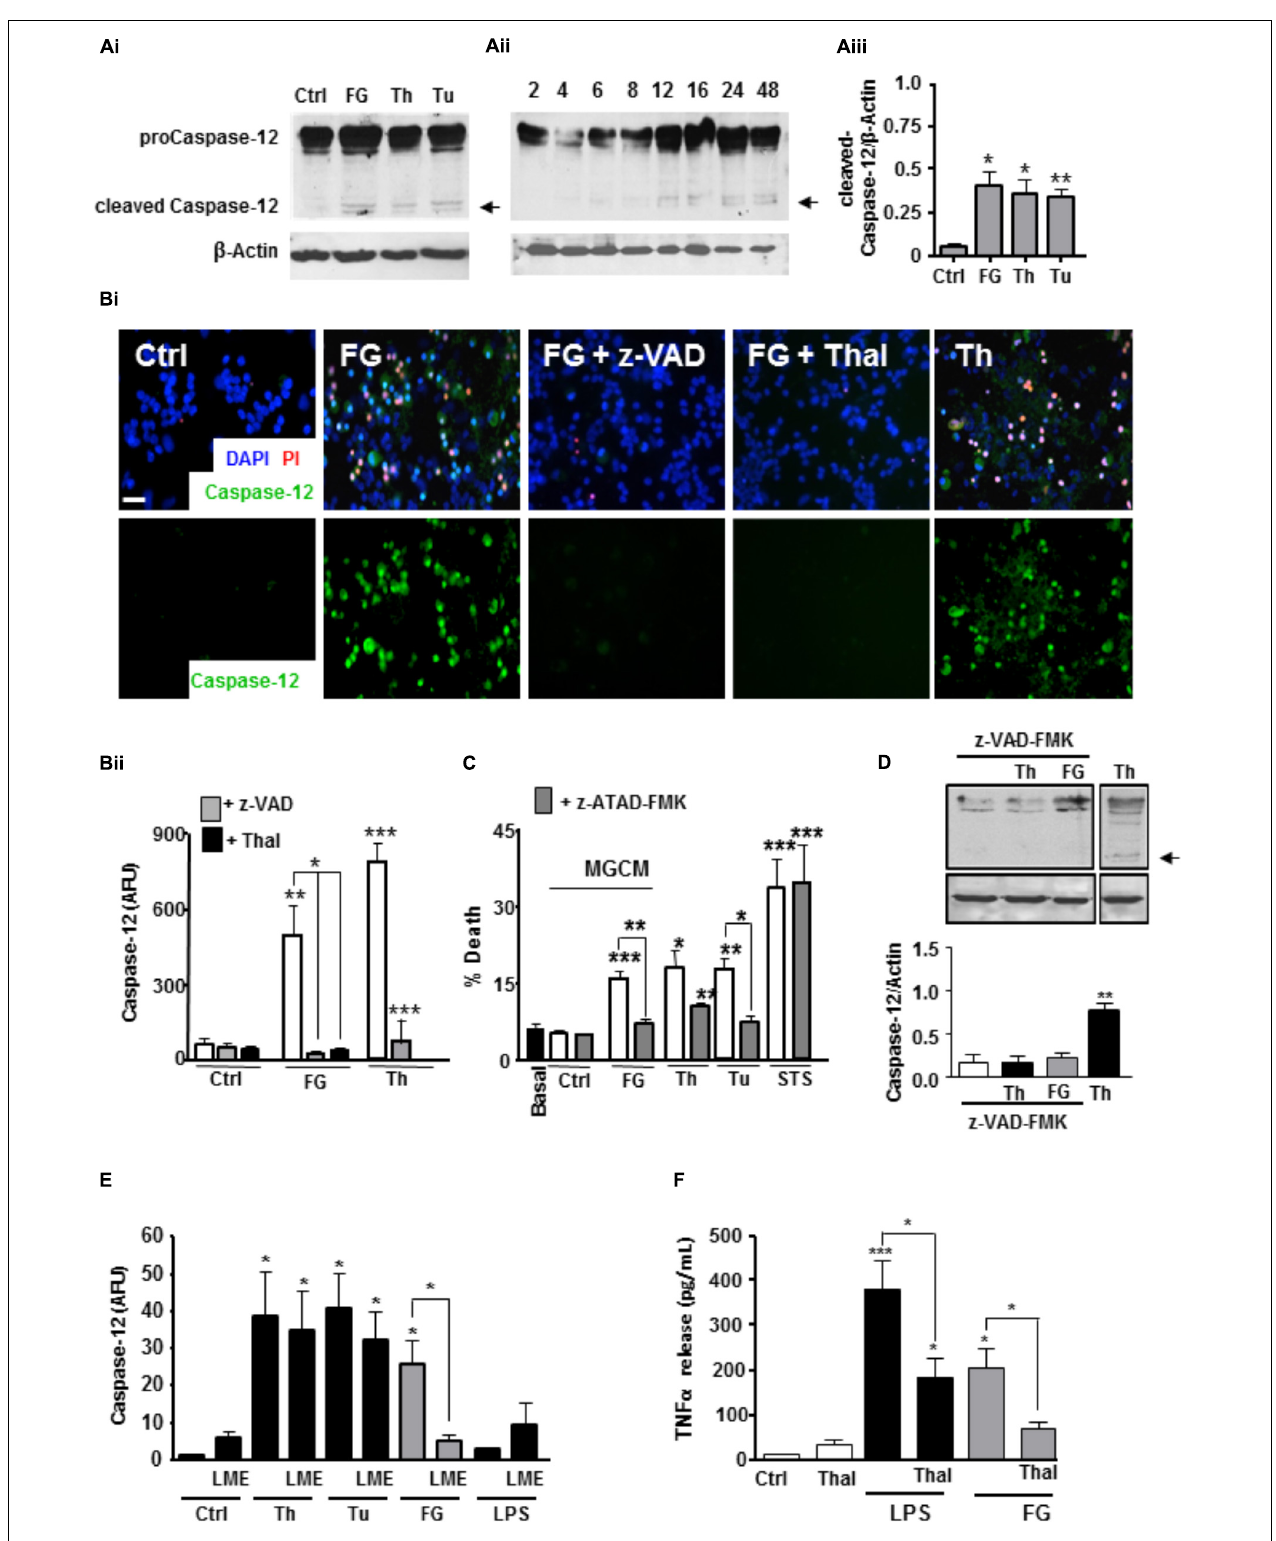
FIGURE 4 | FG inducesneuronal ER stress signaling via microglial TNF α release. (A) Expression of pro-caspase 12 (55 kDa) and cleaved active caspase 12 (36 kDa) in ENGCs from control cultures (Ctrl), or cultures treated with FG (2.5 mg/ml), thapsigargin (Th, 2 µ M), or tunicamycin (Tu, 1 µ g/ml) for 24 h as shown in